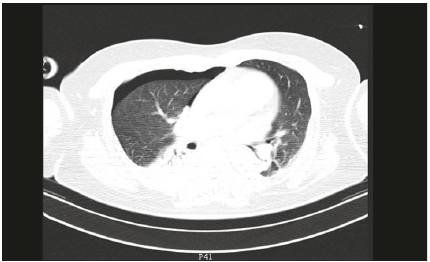
Figure 2: CT in the thorax showing right hemothorax and pneu-